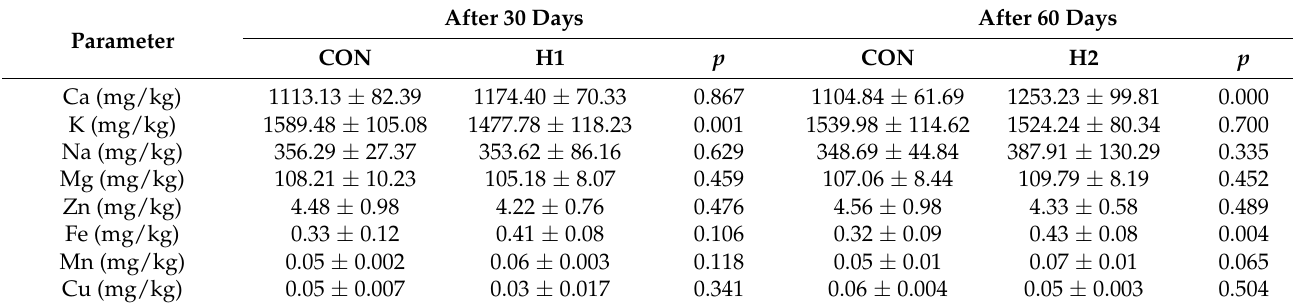
Table 5. Effect of the addition of oxyhumolite to the diet on the mineral profile of milk (Mean ± SD). After 30 Days After 60 Days Parameter CON H1 p CON H2 p Ca (mg/kg) 1113.13 ± 82.39 1174.40 ± 70.33 0.867 1104.84 ± 61.69 1253.23 ± 99.81 0.000 K (mg/kg) 1589.48 ± 105.08 1477.78 ± 118.23 0.001 1539.98 ± 114.62 1524.24 ± 80.34 0.700 Na (mg/kg) 356.29 ± 27.37 353.62 ± 86.16 0.629 348.69 ± 44.84 387.91 ± 130.29 0.335 108.21 ±